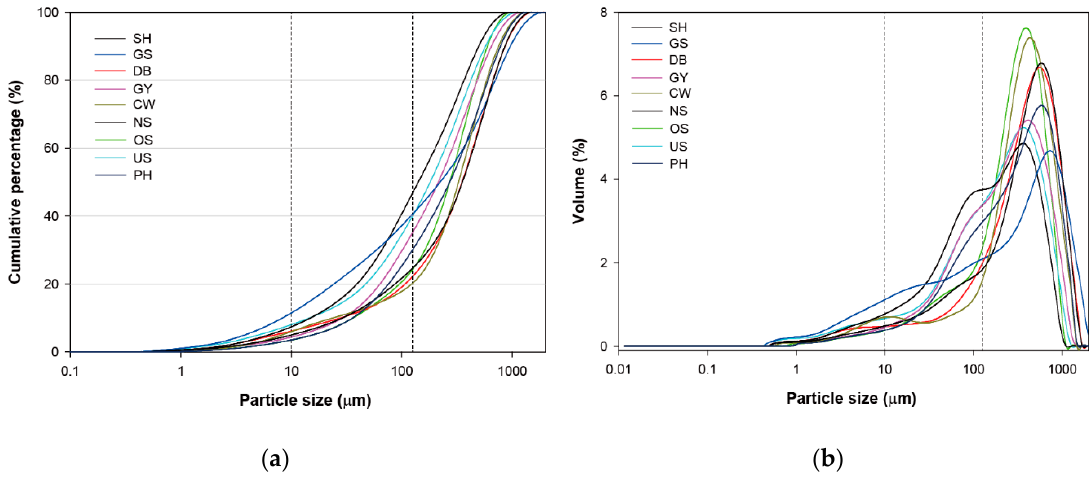
Figure 5. Cumulative curves ( a ) and particle size distributions ( b ) in the RD samples from different national industrial areas of this study.